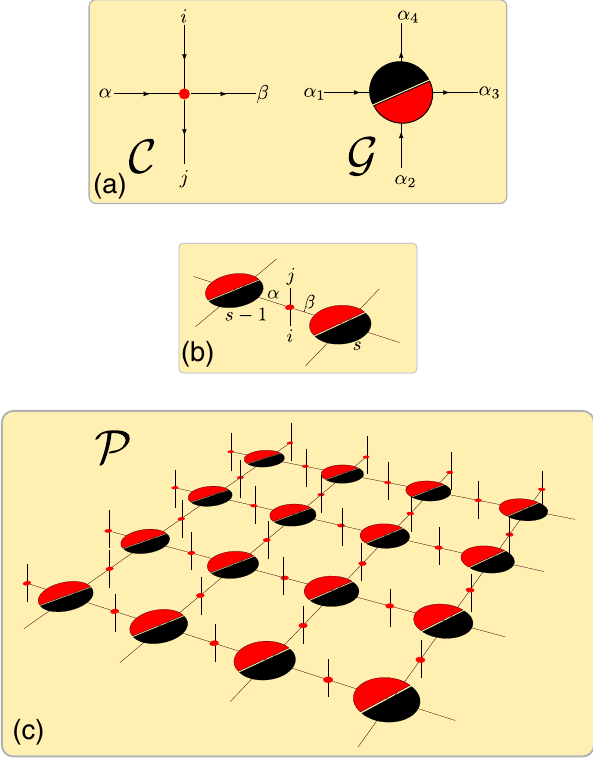
FIG. 10. The projector on the gauge-invariant states. (a) The corresponding TN is defined through the contraction of several copies of two elementary tensors C , which copies the physical Hilbert space onto the auxiliary Hilbert space, and G , which selects only configurations fulfilling the gauge invariance con- dition. (b) An example of gauge-constraint decoupling at sites s − 1 and s obtained through the insertion of the copy tensor C . (c) The projector on the gauge-invariant states for a 4 × 4 square lattice with periodic boundary